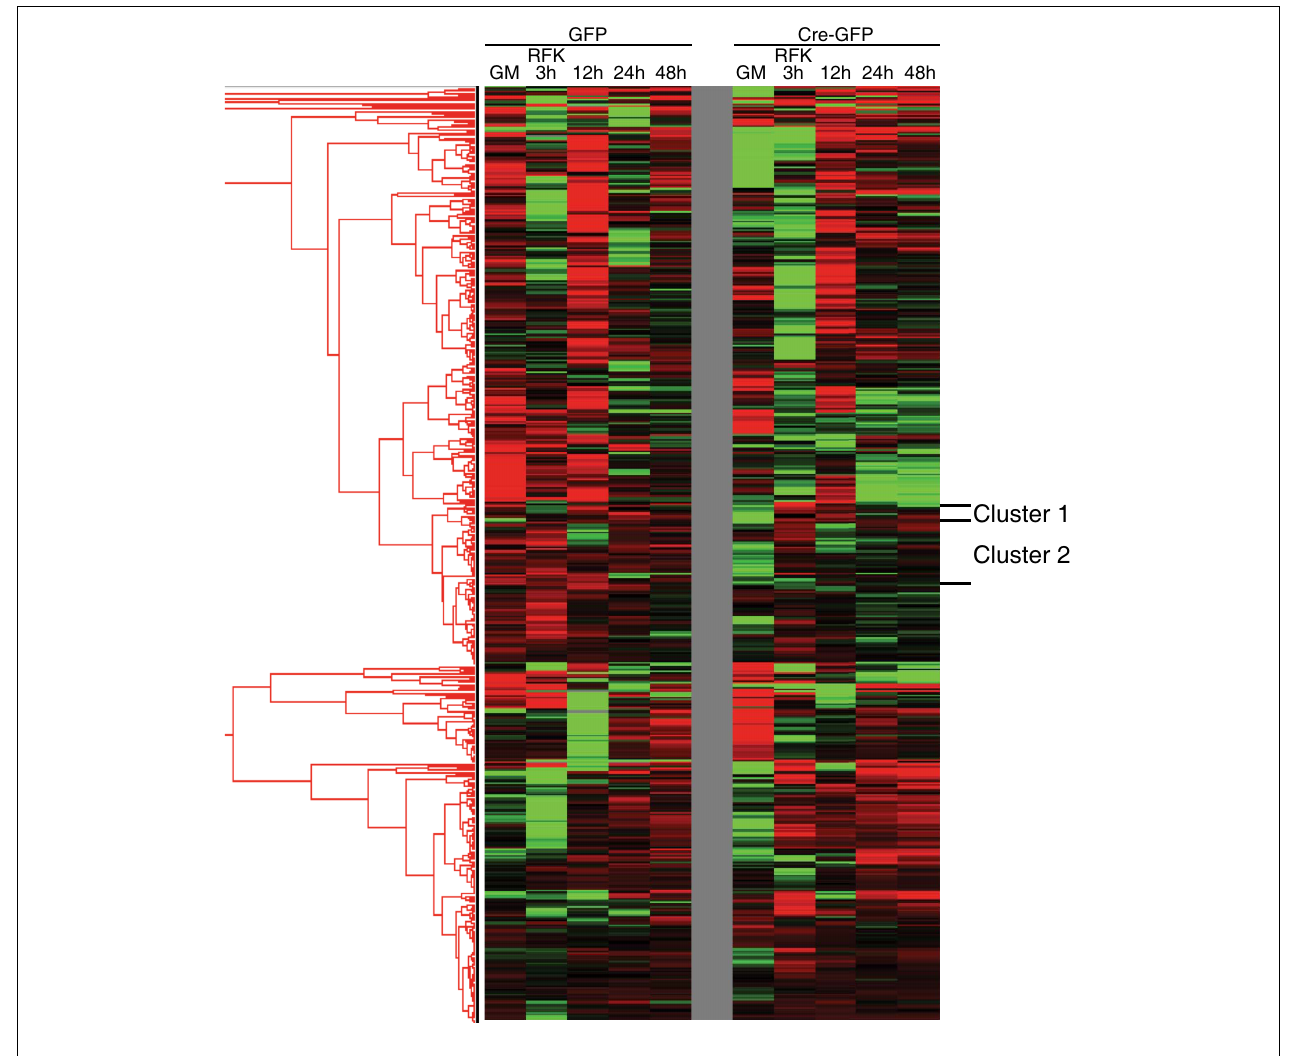
presented in Figure 3.Through bioinformatic and ChIP-seq analysis, we identified numerous potential novel REST miRNA targets residing within the same clusters as known REST miRNA targets (refer to TableA7 in